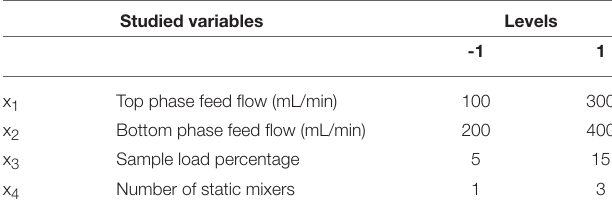
TABLE 2 | Variables and levels of the central composite design (CCD) carried out for enzyme recovery from spent brewer’s yeast using the pilot plant prototype. Studied